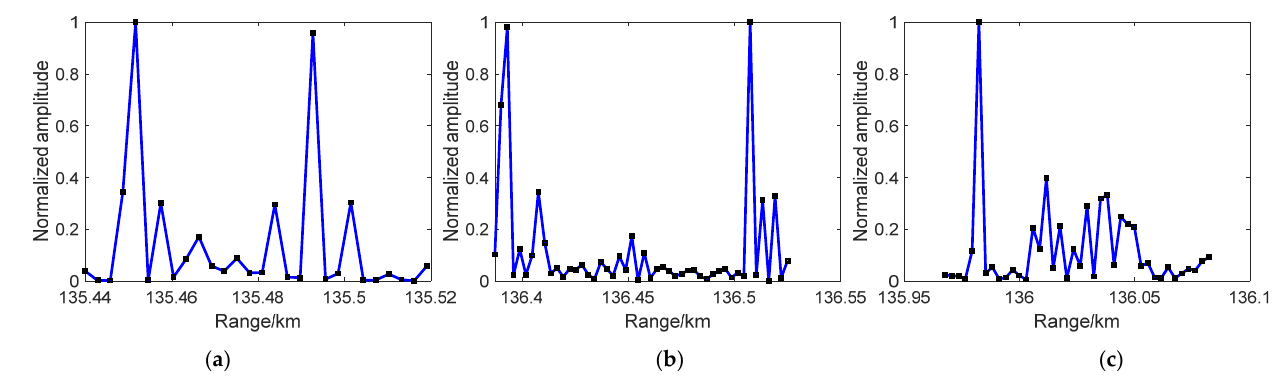
Figure 14. Range inversion results of 3 ship targets under the detection of BDS satellite 3 with range inversion method 1: